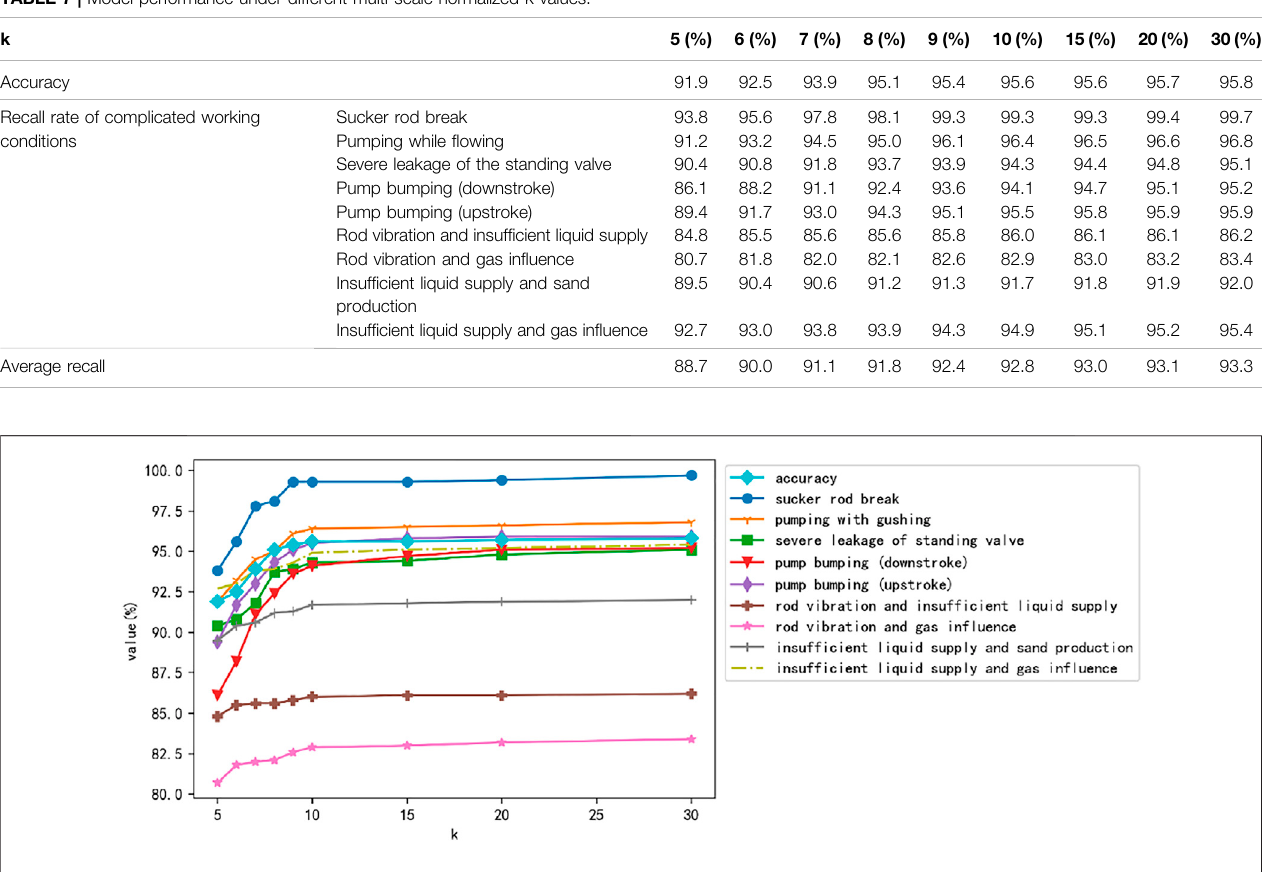
FIGURE 9 | The change trend of model performance with k value.